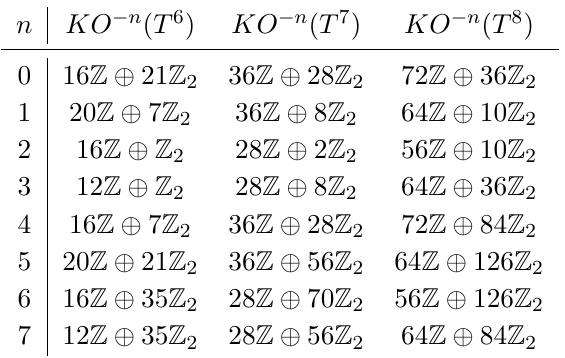
Table 31 . KO-groups of tori KO − n ( T k ) , k = 6 , 7 , 8 .